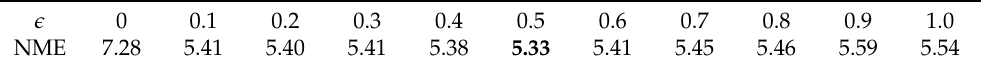
Table 8. Ablation experiments of hyperparameter (cid:101) on 300 W